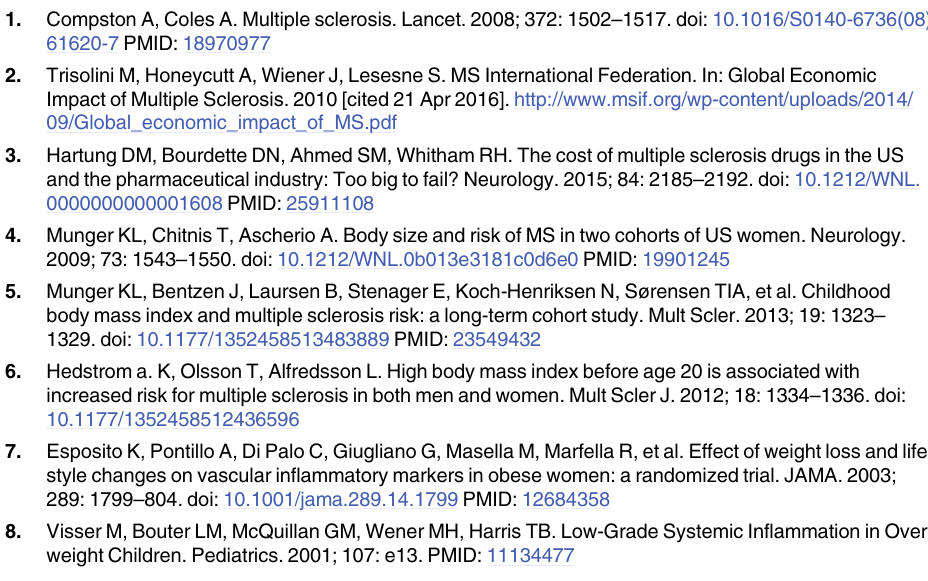
While it appears that the slopes of the two lines diverge, we note that the MR-Egger crosses the null and includes our original MR estimate within its 95% CI. S1 Table. BMI SNPs in LD with previously reported height loci. BMI SNPs that overlap with height loci previously reported in GIANT ’ s 2014 GWAS. SNPs were considered to be in LD if r 2 > 0.05. S2 Table. Characteristics of SNPs from IMSGC/WTCCC2-only sensitivity analysis. This table provides the genetic effect sizes and p -values for the association of the BMI SNPs with MS in the IMSGC/WTCCC2